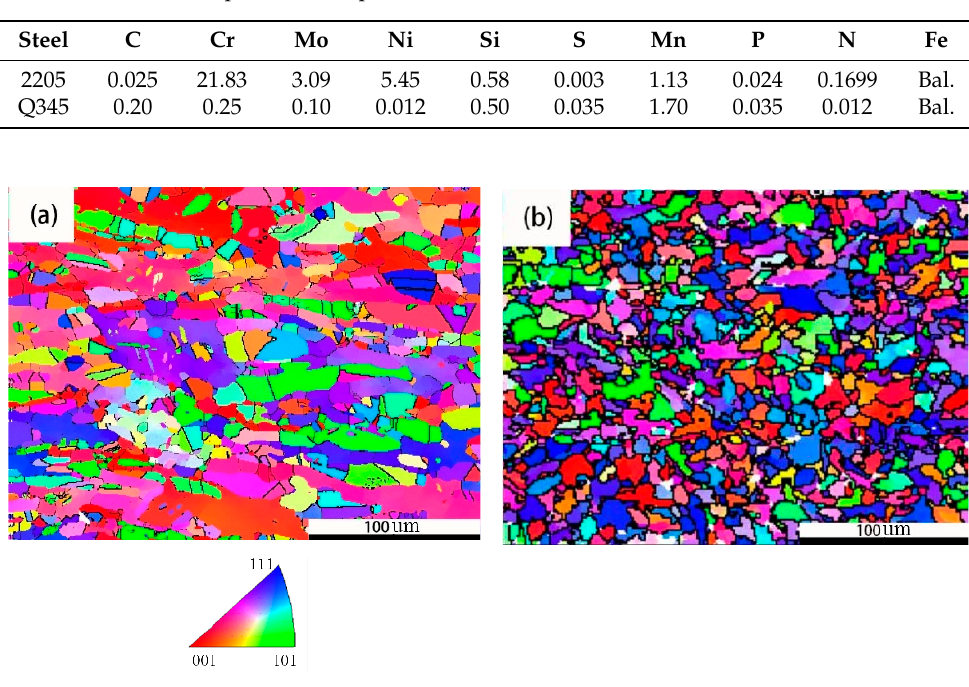
Figure 1. The initial microstructures of 2205 duplex stainless steel ( a ) and Q345 carbon steel ( b ).